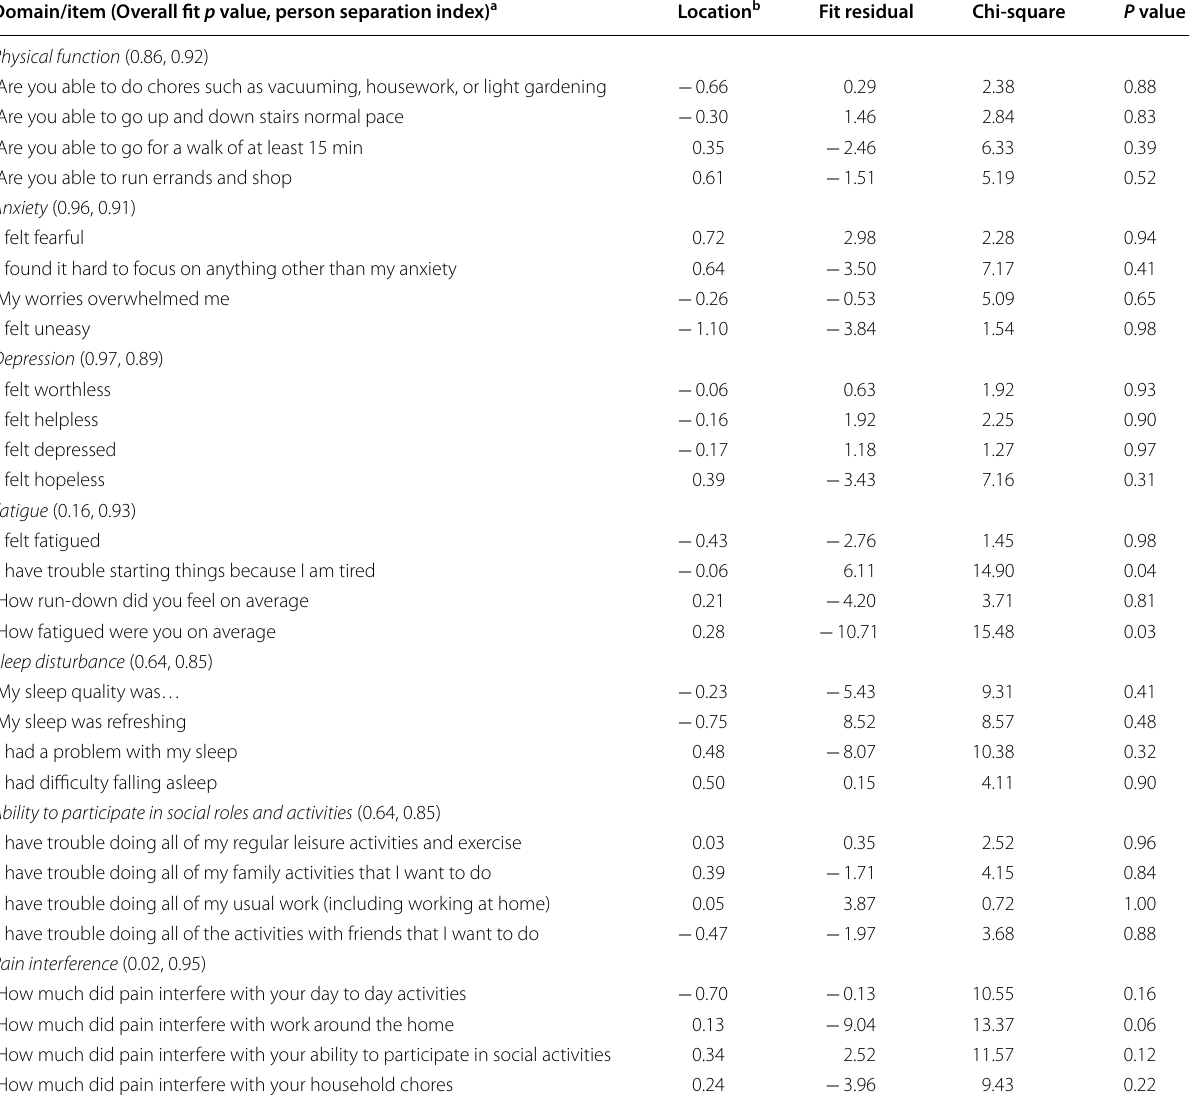
Table 3 Rasch analysis for the seven domains of the Norwegian PROMIS-29 Domain/item (Overall fit p value, person separation index)